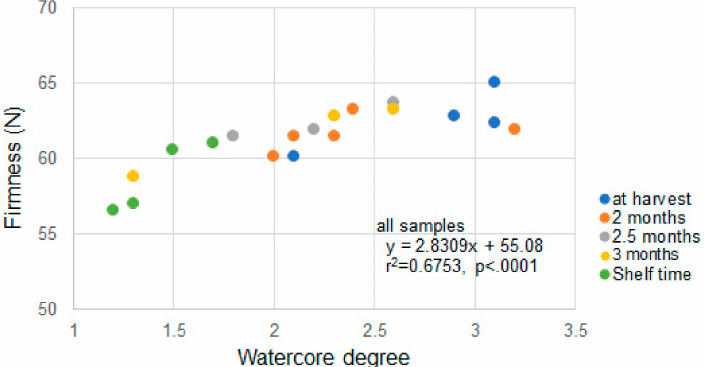
Figure 4. Watercore degree (0–4) and flesh firmness of ‘Fuji’ apple. Reproduced with permission from Onodera